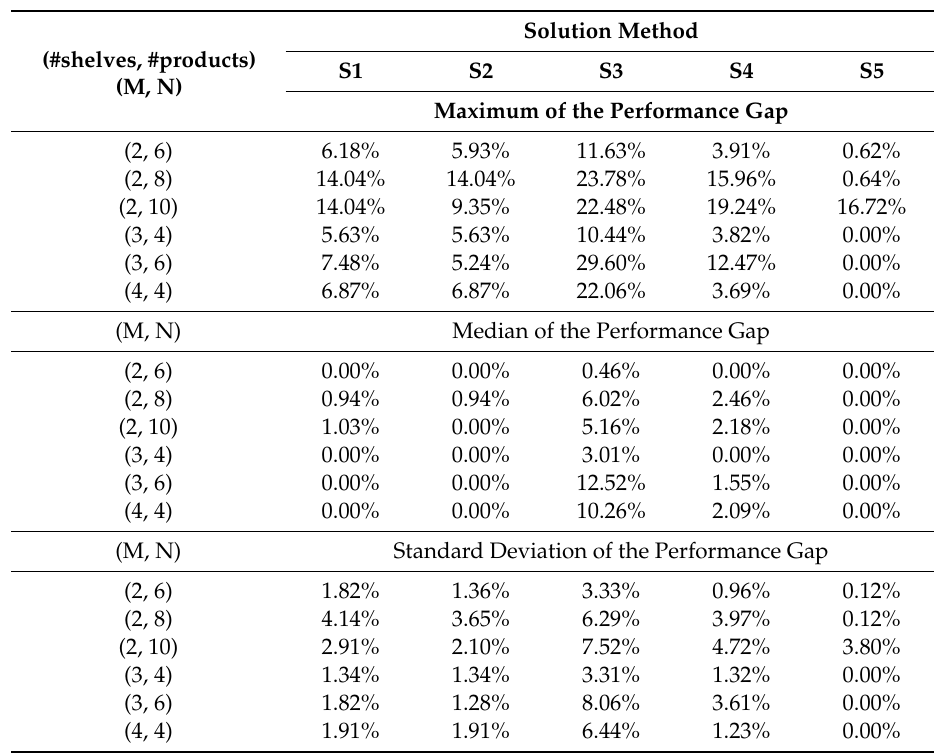
Table 6. The maximum, median, and standard deviation of the performance gap under di ff erent (M, N).